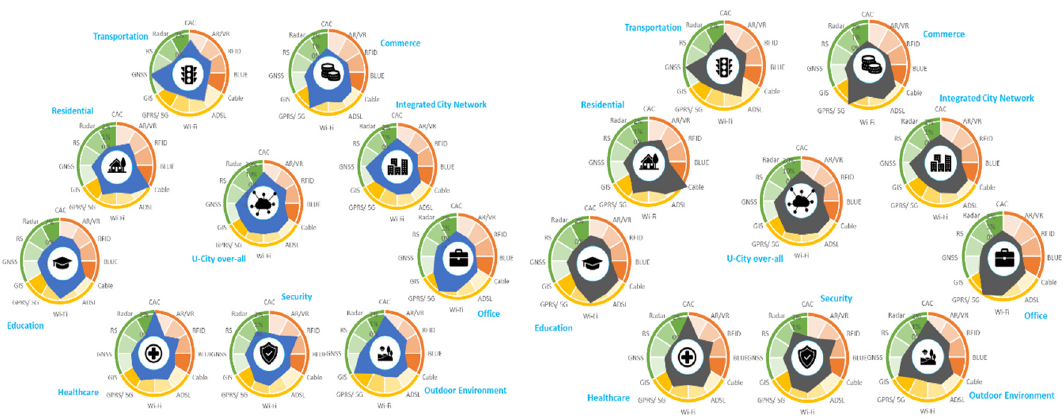
Figure 10. Detailed vulnerabilities of service areas against man-made hazards (on left ) and natural hazards (on right ).